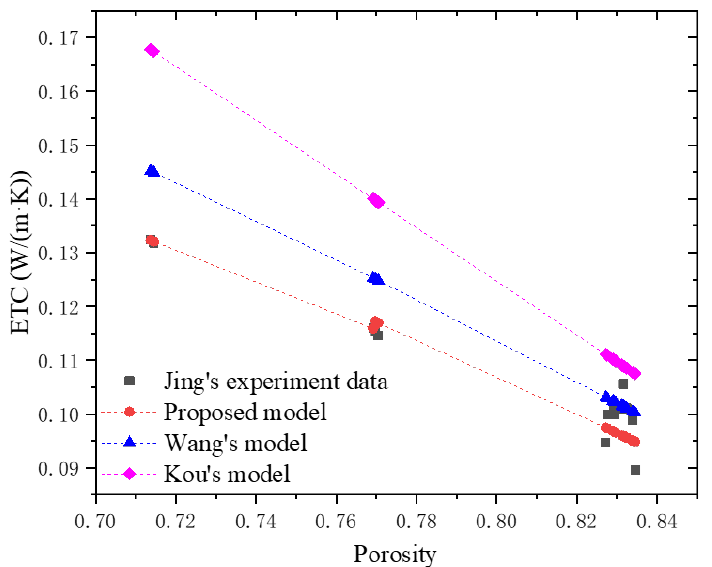
Figure 4. The calculated results are compared with the experimental data of Jing [28] and the com- parison of calculation results of different ETC models. comparison of calculation results of different ETC